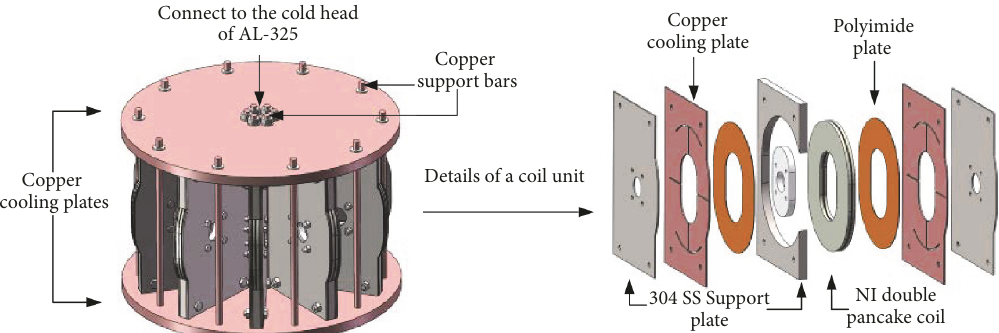
Figure 2: Structure details of the NI toroidal magnet and each double-pancake coil.